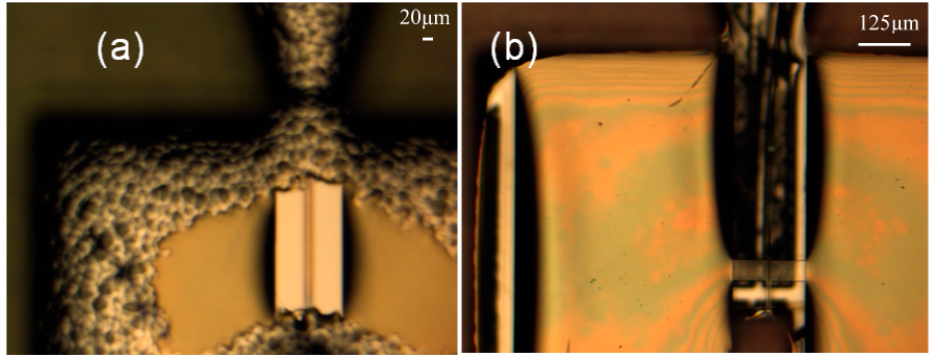
Figure 17. ( a ) The 750 ‐ deep reactive ion etching cycles were used to release the scanner (picture is taken from the backside), ( b ) 30 additional cycles were later added to further remove the Si residue around the edges of the window.